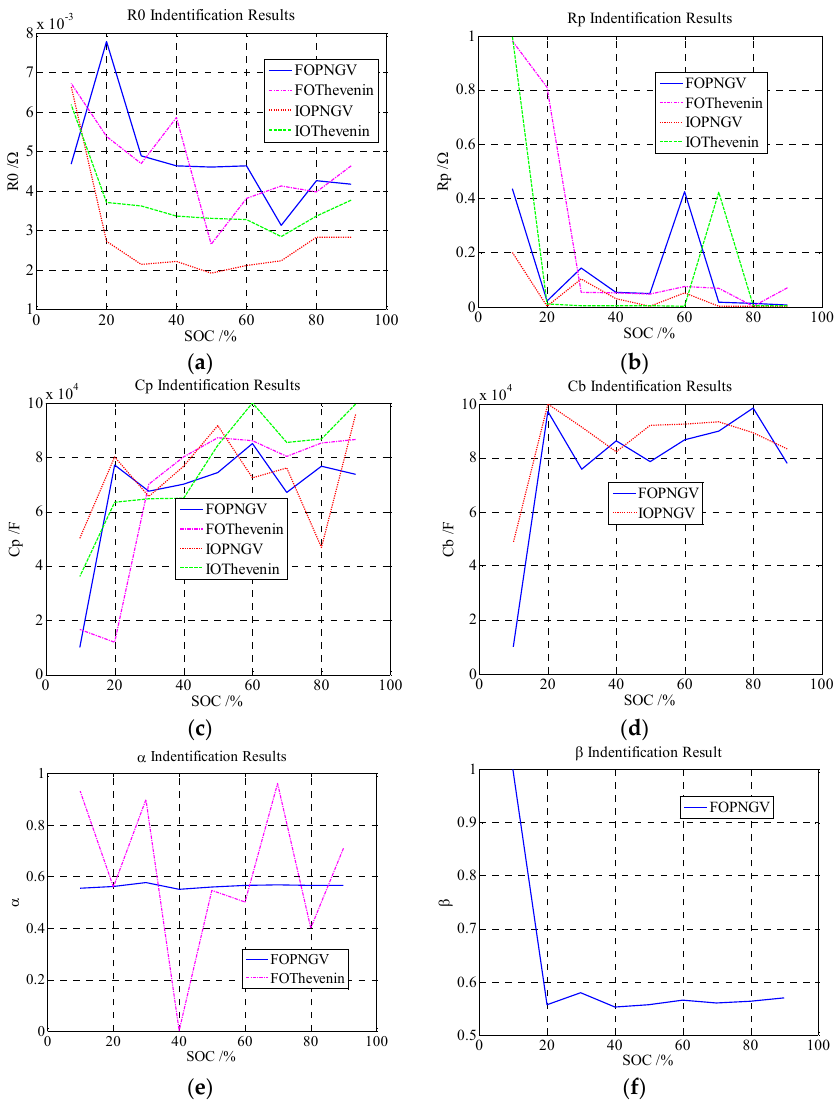
Figure 6. The relationship between the parameters and SOC ( a ) R 0 ; ( b ) R p ; ( c ) C p ; ( d ) C b ; ( e ) α ; ( f ) β .